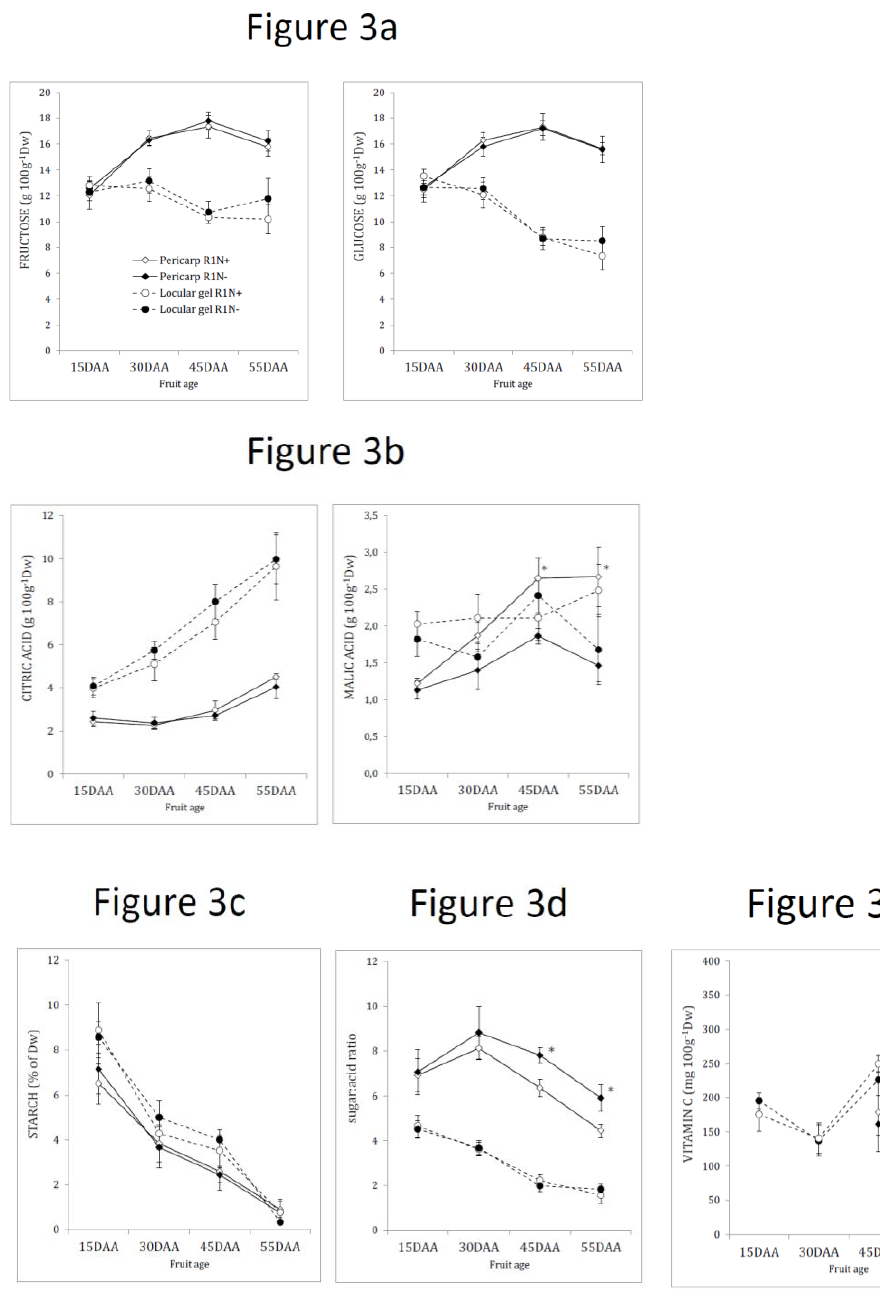
Figure 3. ( a ) Fructose and glucose contents, ( b ) citric acid and malic acid contents, ( c ) starch content, ( d ) sugar:acid ratio and ( e ) vitamin C content in pericarp and locular gel during the ripening of tomato fruits of R1 according to nitrogen supply N+ and N − . Fructose, glucose, citric acid and malic acid contents are expressed in g 100g − 1 of dry weight. Starch content is expressed in % of dry weight. Sugar:acid ratio has no unit. Vitamin C (reduced + oxidized forms) is expressed in mg 100g − 1 of dry weight. Pericarp material is presented in squares with dark lines, locular gel in circles with dotted lines. Black symbol represents N − , white symbol represents N+. Errors bars represent the standard deviation. One star indicates significant difference between nitrogen treatments. Complete statistical analysis is available in Table